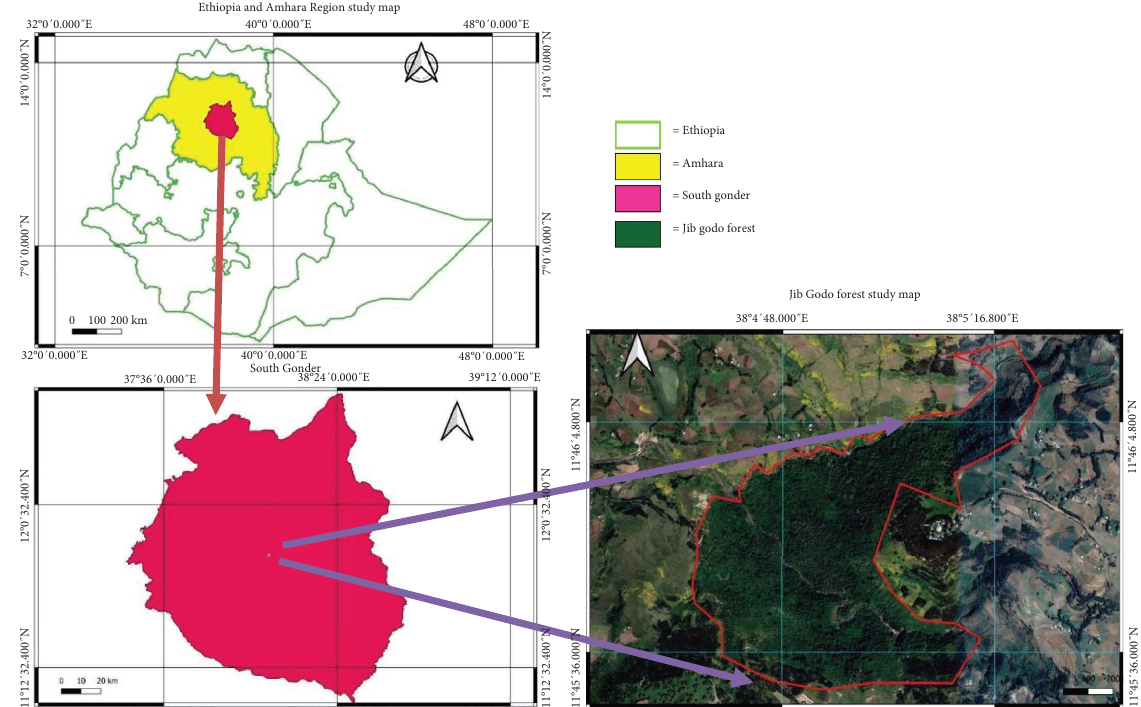
Figure 1: Location map of Jib Godo Natural